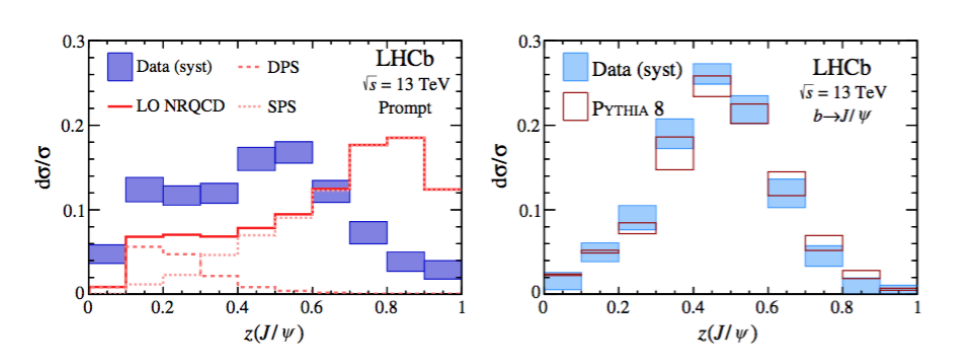
Figure 3: Measured z distributions for prompt J /ψ (left) and from b -decay (right) (cid:112) s = 13 TeV [ 17 ] at